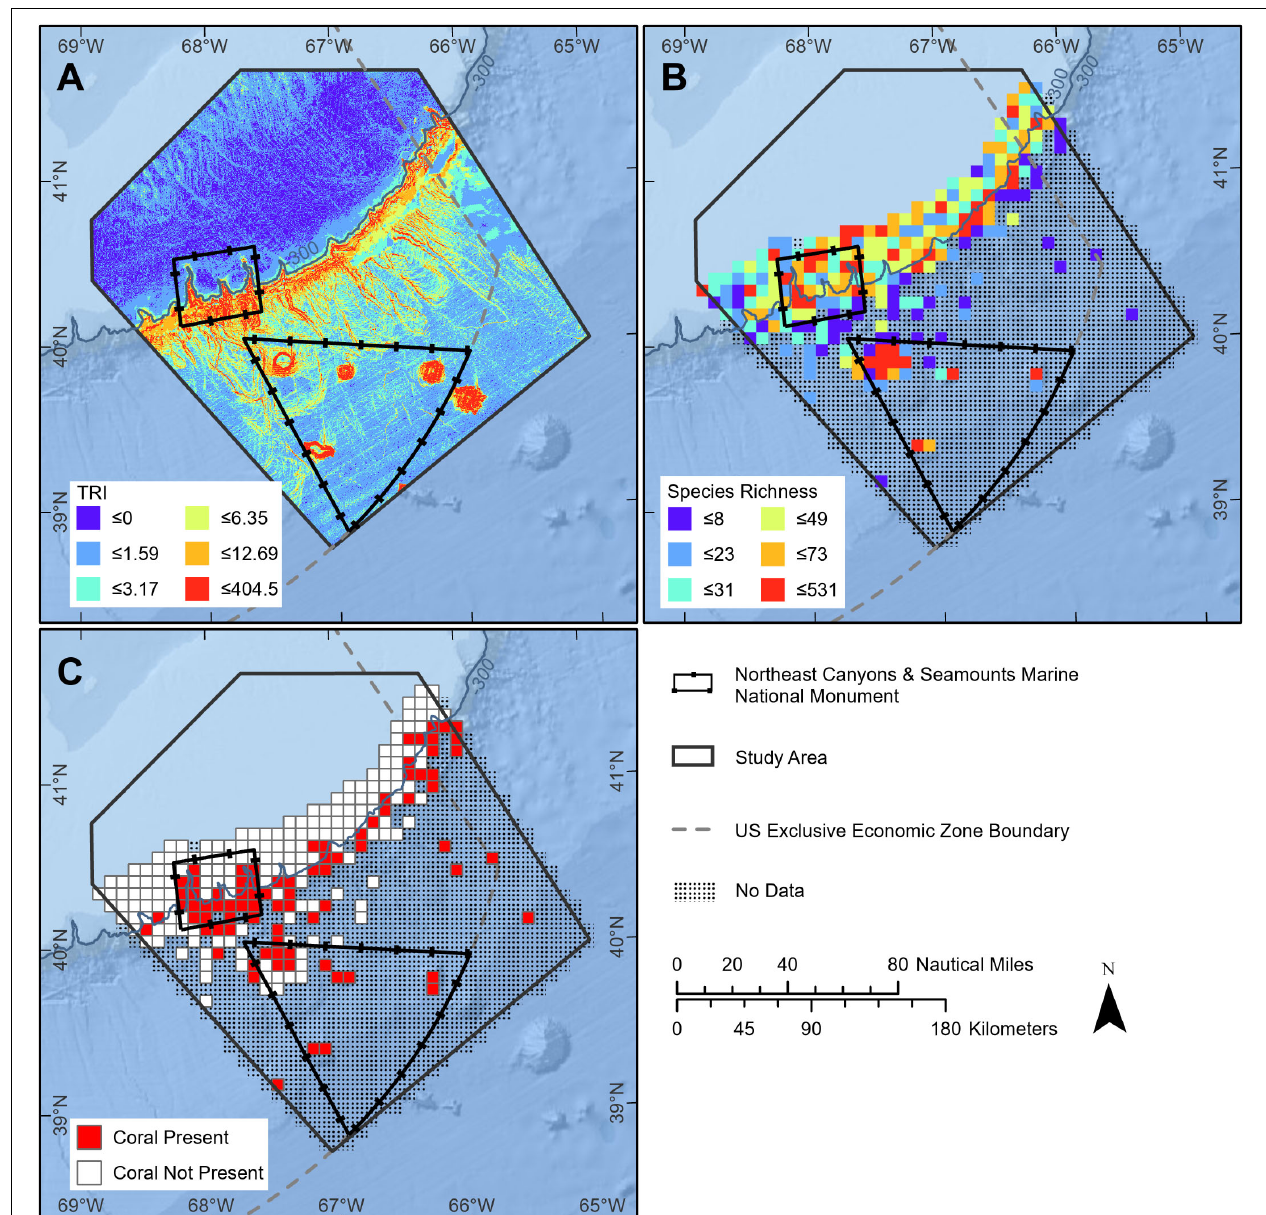
FIGURE 2 | Attributes of the seafloor and associated species in the monument region (slides are based on Kraus et al., 2016 with designated boundary configuration). (A) Topographic roughness index based on bathymetry shows the variability in medium-scale habitat complexity with warmer colors (reds) indicating steepest terrain. (B) Species richness of seafloor fauna (invertebrates and demersal fishes) aggregated from multiple types of sampling programs. Note hotspots occur in canyons and on seamounts. (C) Grid cells with documented presence of deep-sea corals. Supplementary Appendix 1 summarizes details of the geospatial analyses presented